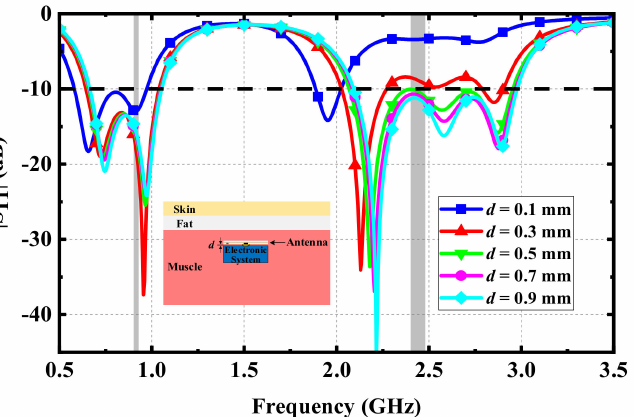
Figure 8. Simulated |S 11 | varying with the distance between the proposed antenna and the electri- cal